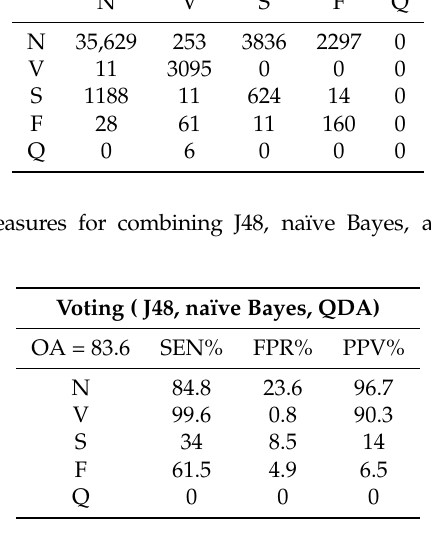
Table 12. Confusion matrix for combining J48-C, naïve Bayes, and QDA classifiers using a Voting